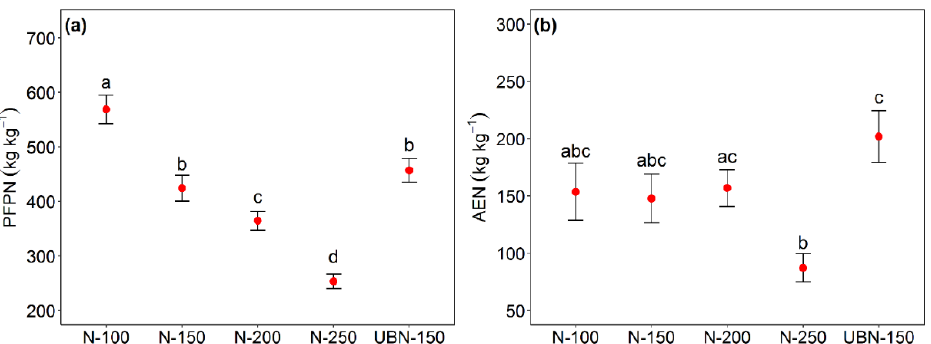
Figure 5. Average partial factor productivity of N (PFPN ( a )) and agronomic N use efficiency (AEN ( b )) of various N rates and sources across districts; mean ± SE. Different letters above an error bar represent significant differences between different N treatments (post hoc Tukey test, p < 0.05).